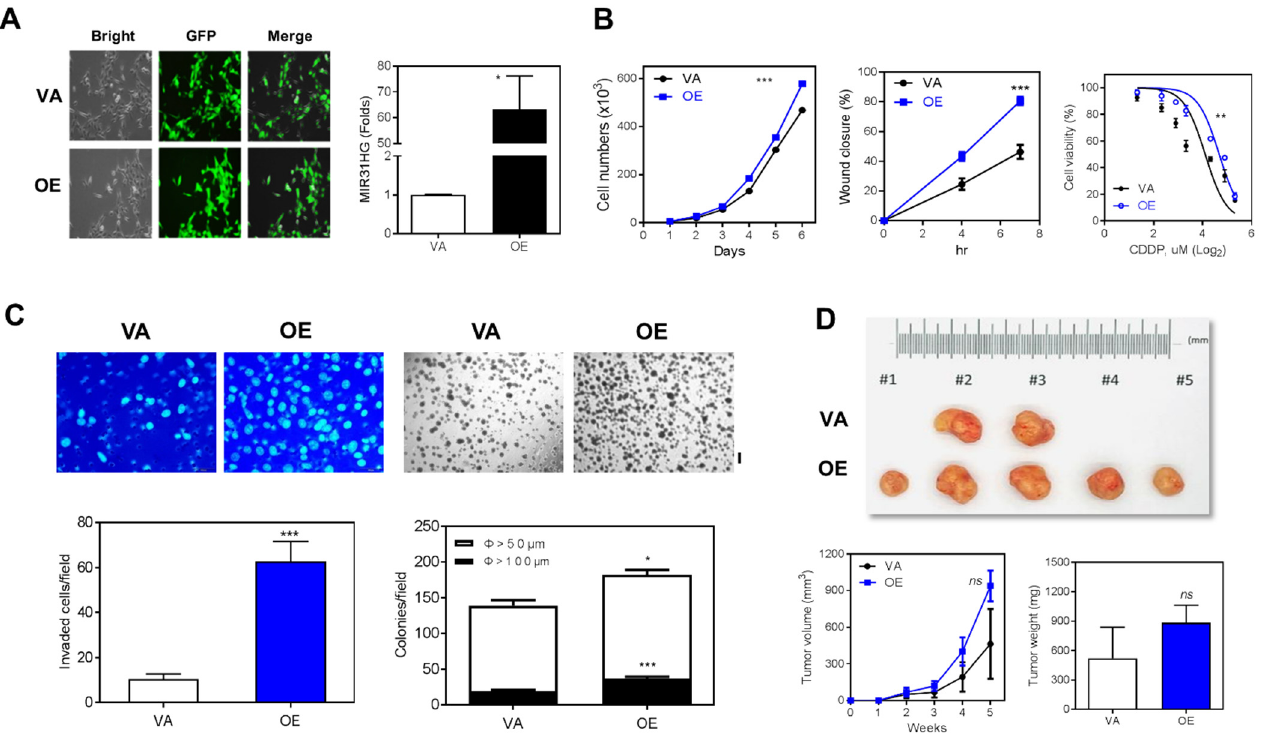
Figure 2. Exogenous MIR31HG overexpression increases the oncogenicity of SAS cells. ( A ) Left, stable cells with exogenous MIR31HG overexpression and control cells both exhibit green fluorescence indicating the presence of plasmid. Right, qRT- PCR analysis shows that there is increased MIR31HG expression in OE cells. ( B ) OE cells exhibit an increased proliferation (Left), increased wound closure rate (Middle) and higher cisplatin resistance (Right) relative to VA cells. ( C ) OE cells exhibit increased invasion (Upper Left) and higher colony formation ability (Upper Right) relative to VA cells. The lower panels show the calculation. Bar, 200 µ M. ( D ) Subcutaneous tumorigenesis assay. Left, resected tumors from the sacrificed animals. Middle, the growth rate of the tumors over a 5-week period. Right, the weight of the resected tumors. VA, vector alone. OE, stable MIR31HG overexpression. *, p < 0.05; **, p < 0.01; ***, p < 0.001.